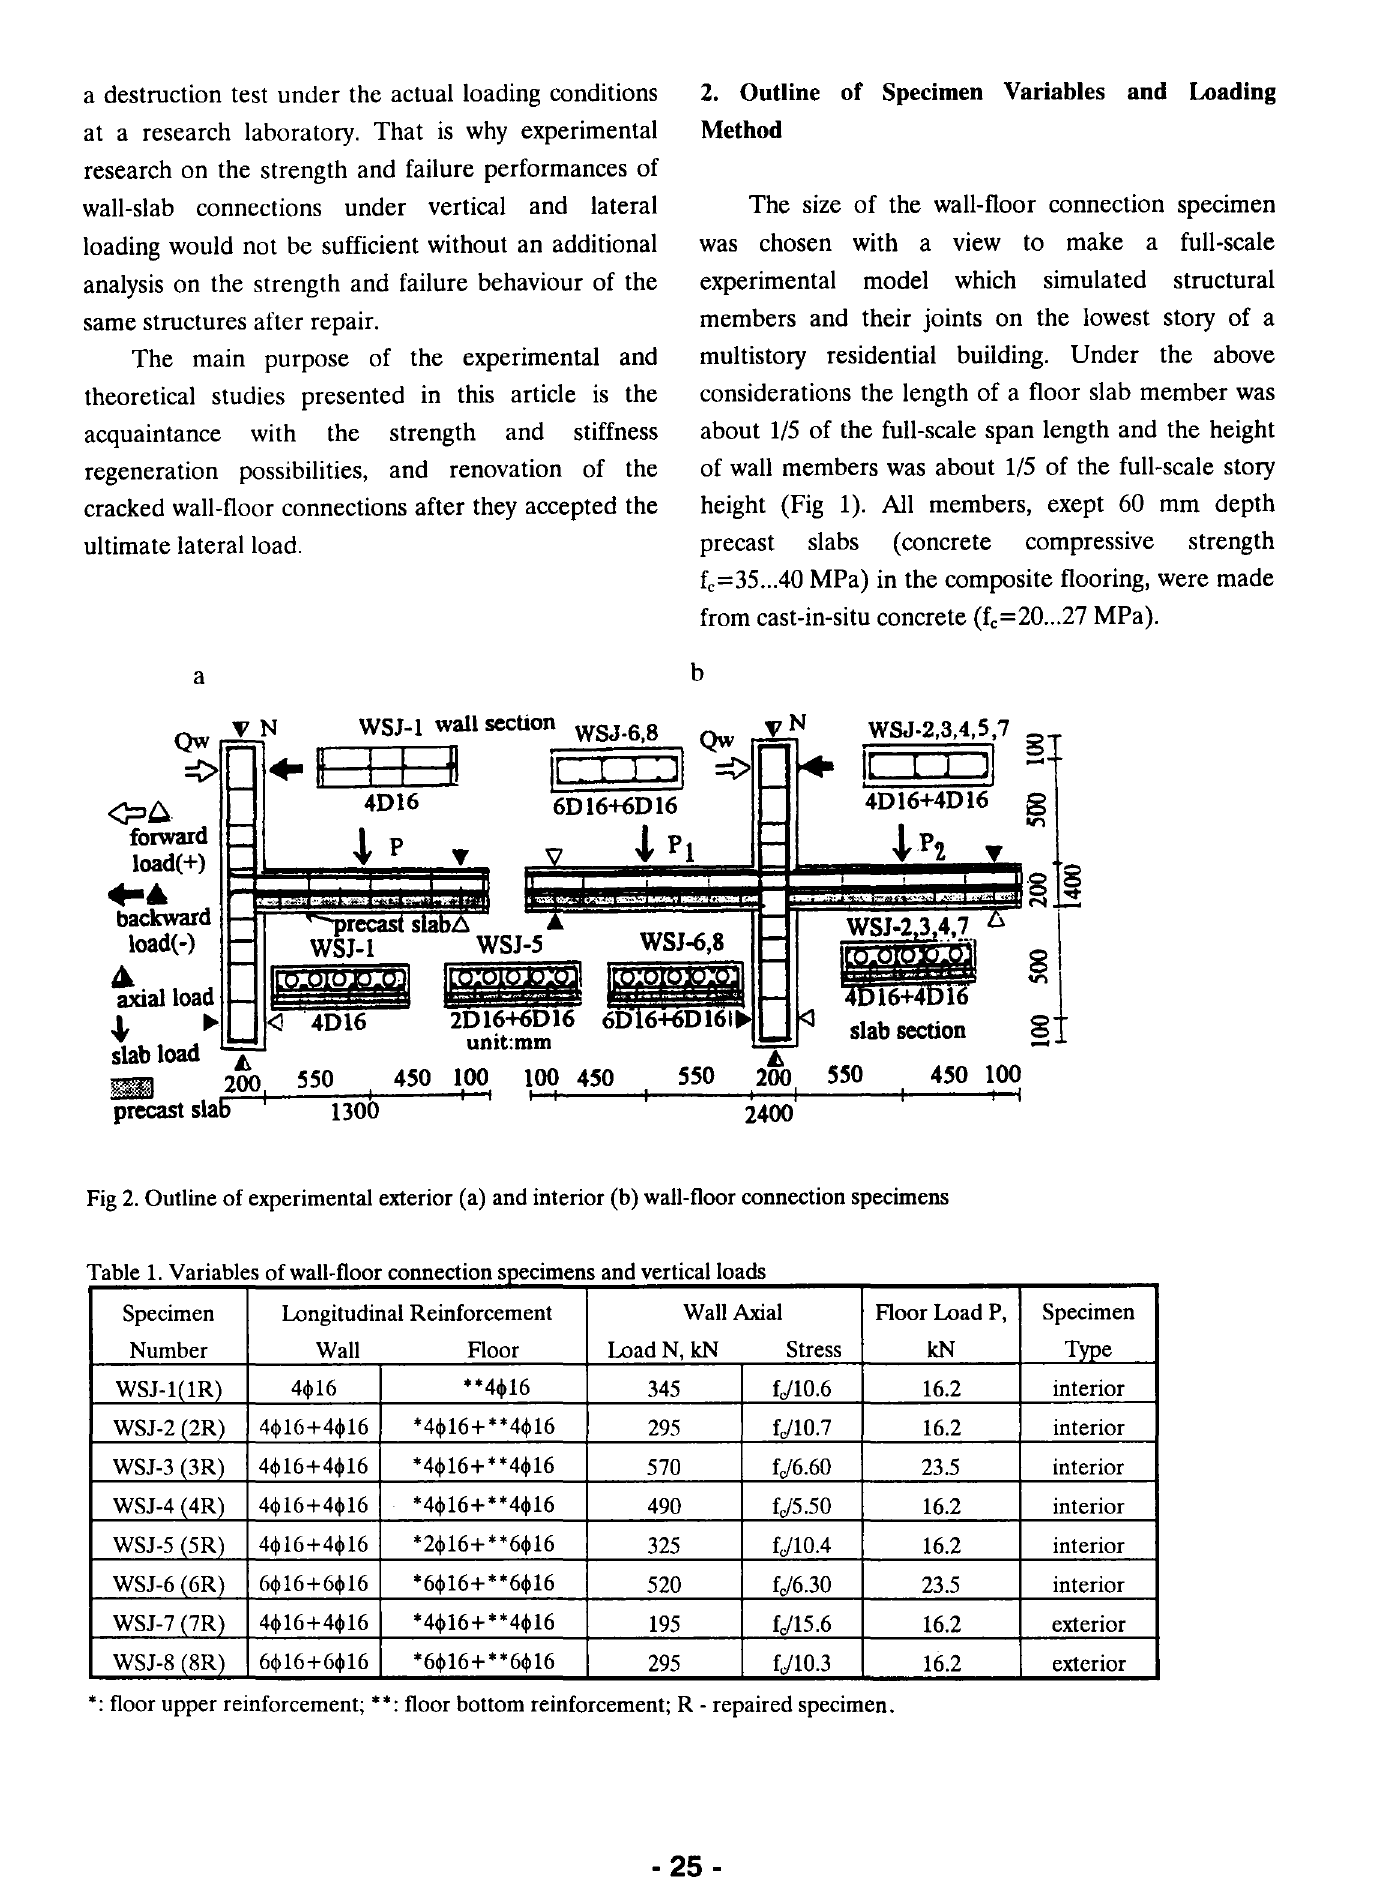
Fig 2. Outline of experimental exterior (a) and interior (b) wall-floor connection specimens a e . ana es o wa - oor connection specimens an T bl 1 V .